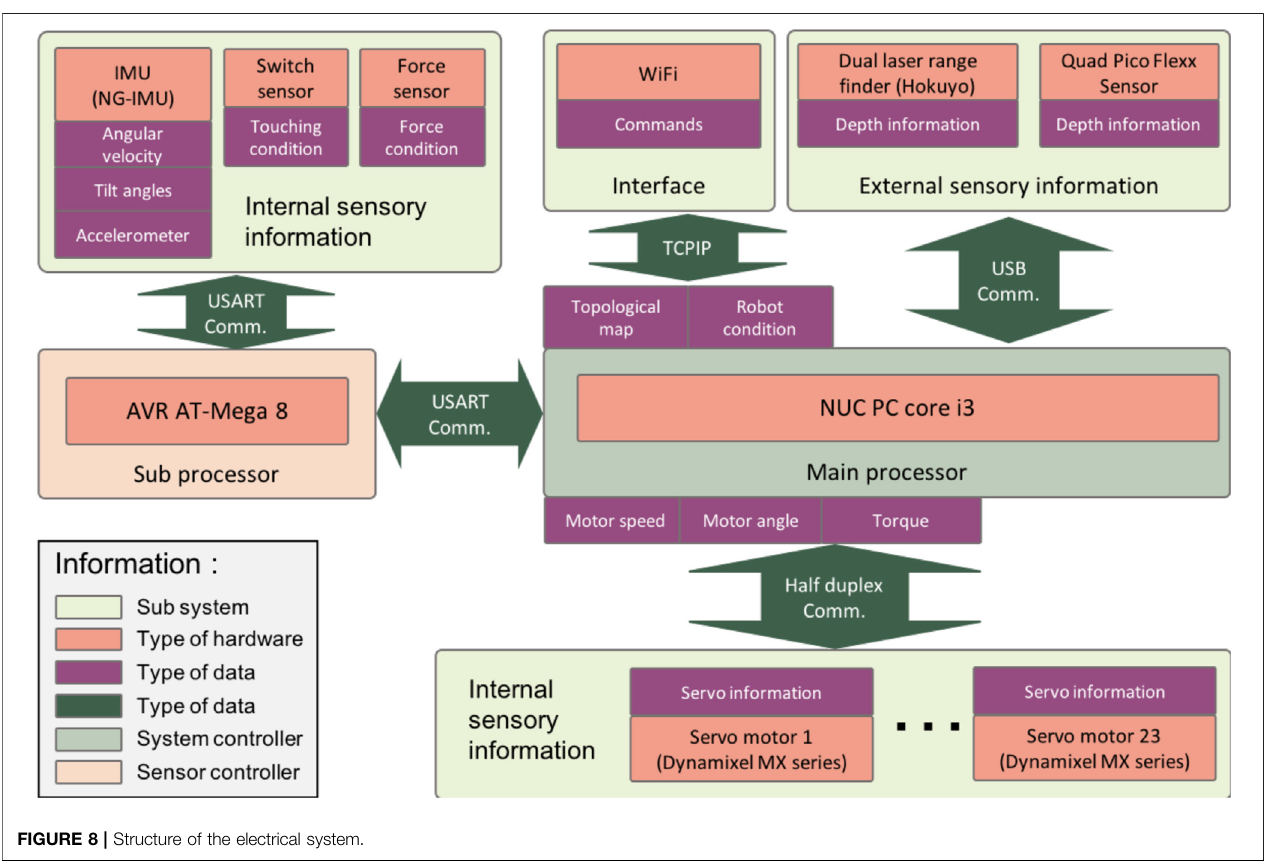
FIGURE 8 | Structure of the electrical system.